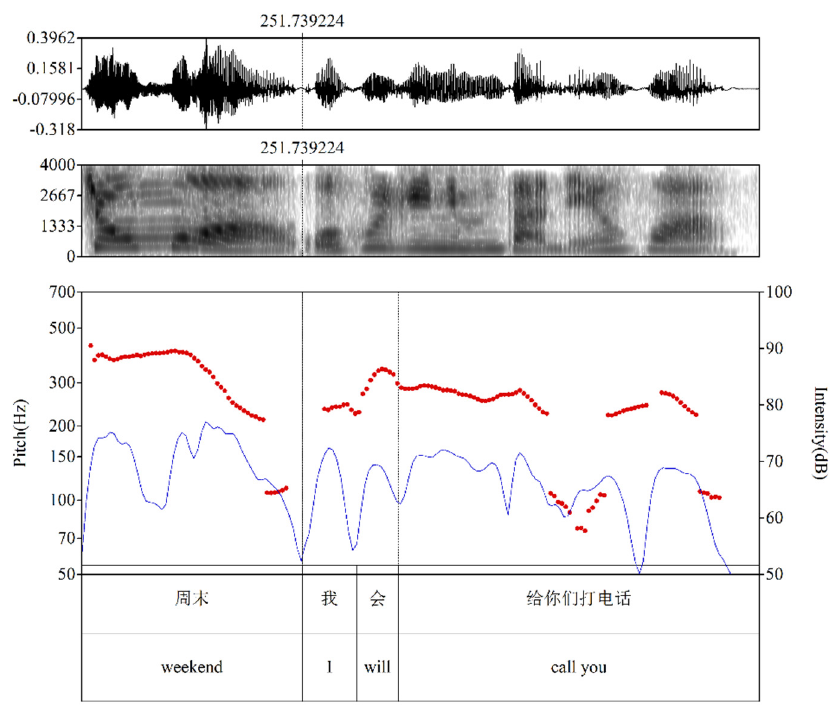
Figure 8. Waveform, spectrogram, pitch contour, and intensity of the second half of line 02 in Ex 16. [ w ǒ huì X ( de )] with unstressed huì in the above examples highlights that the future